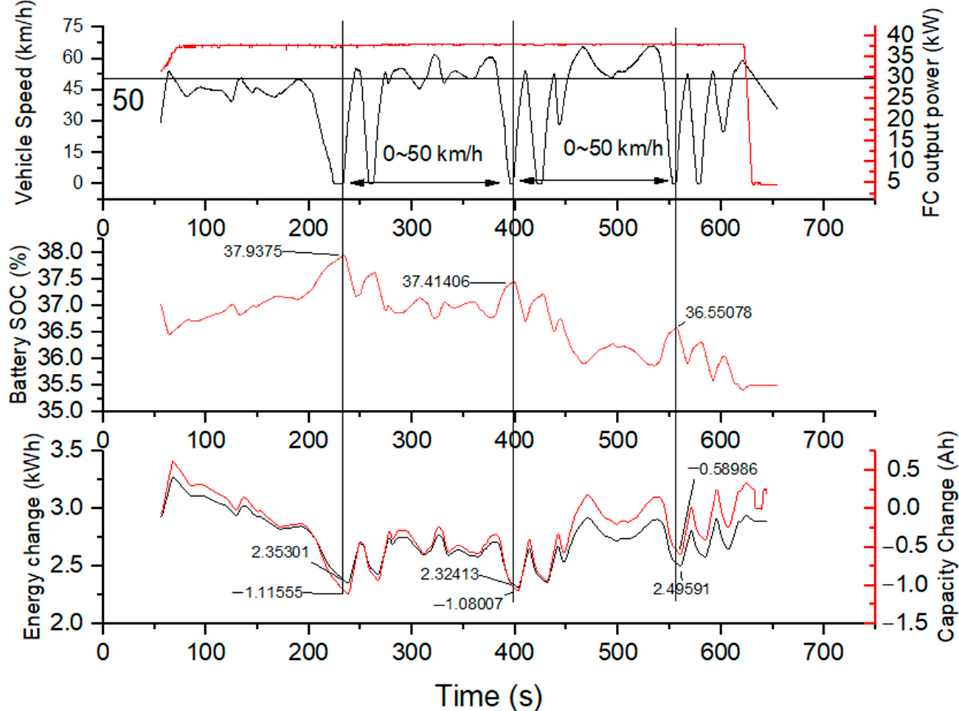
Figure 6. 0~50 km/h acceleration test.